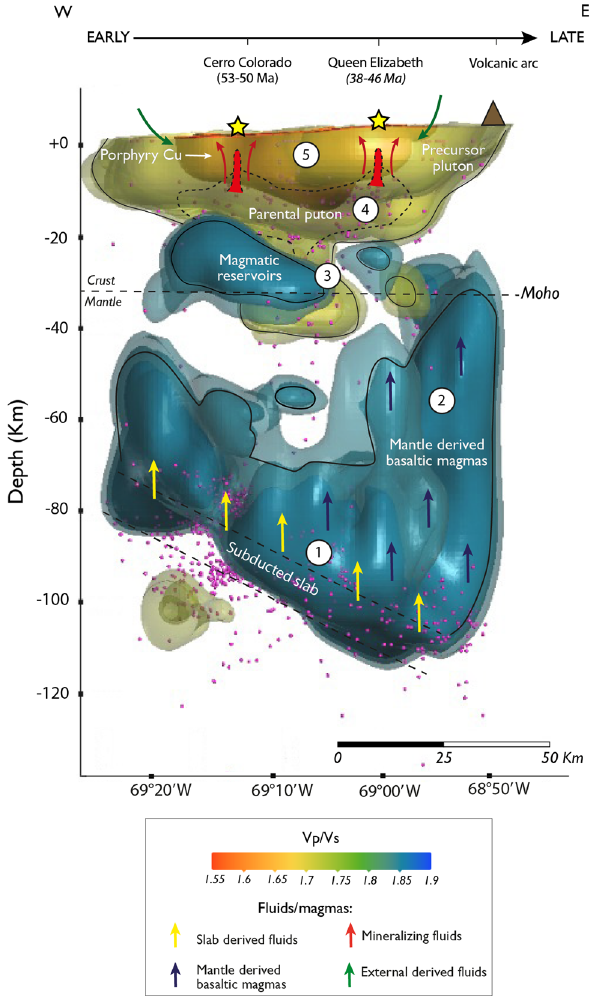
Figure 7. Conceptual model for the formation of the porphyry copper system beneath the study area based on the distribution of the Vp/Vs ratios (see also Supplementary Video S1). Arrows indicate the possible paths of fluids and/or magmas. The dotted lines indicated inferred features and pink circles correspond to the seismicity recorded in the area. We used an average Moho depth from Melnick 52 and Maksymowicz, et al. 53 The numbers indicated inside the circles correspond to the stages of the porphyry system formation (Stages 1 to 5 ) explained in the main text. See text for discussion. Data georeferencing was carried out with ArcGIS Pro10.1 (www. esri. com). The software used to generate this figure was Leapfrog 2022.1 (www. seequ ent. com) and the final editing was done with Adobe Illustrator 2022 (www. adobe.